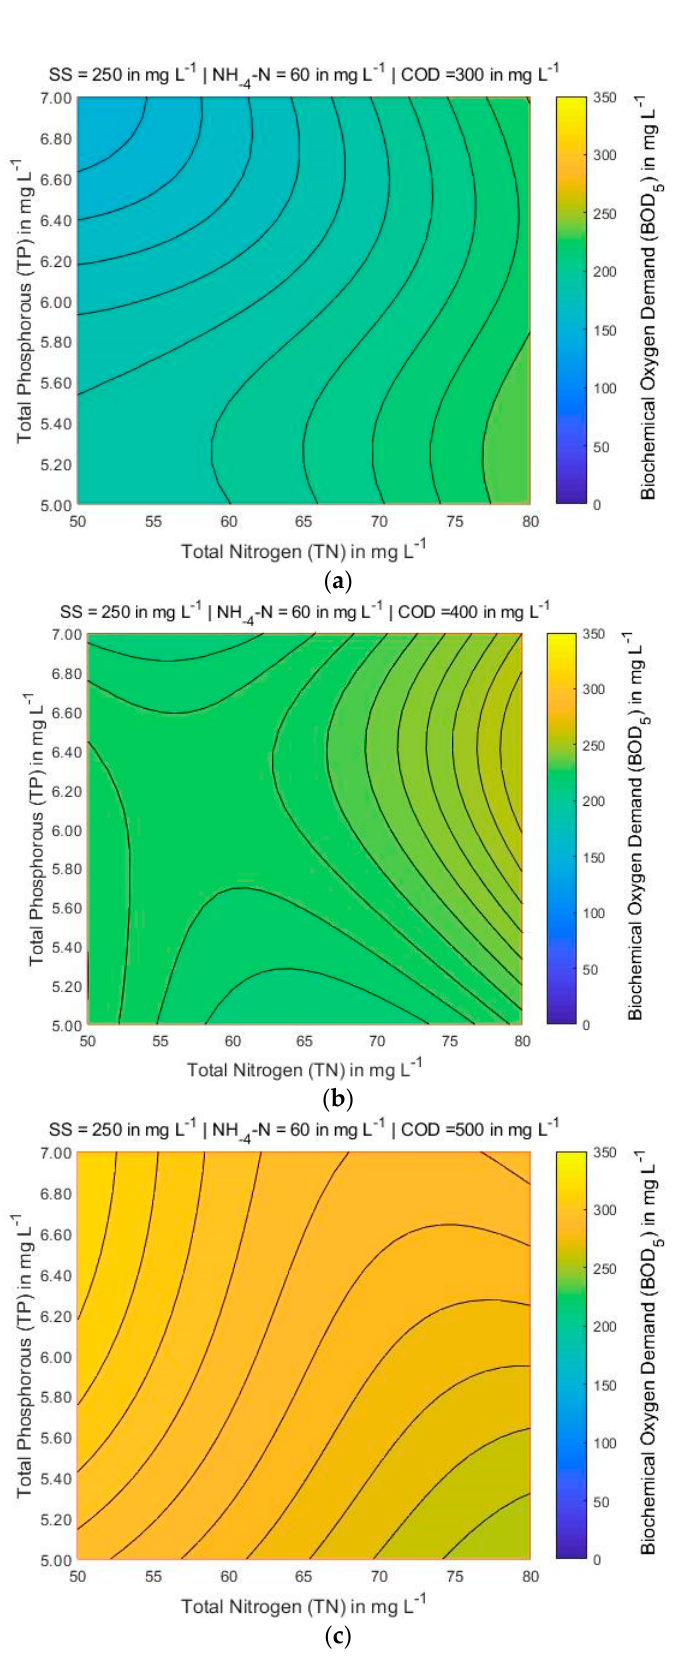
Figure 12. BOD 5 contour maps for three different values of COD (in mg L − 1 ) while SS = 250 mg L − 1 and NH 4 -N = 60 mg L − 1 are constant: ( a ) COD = 300; ( b ) COD = 400; and ( c ) COD = 500.